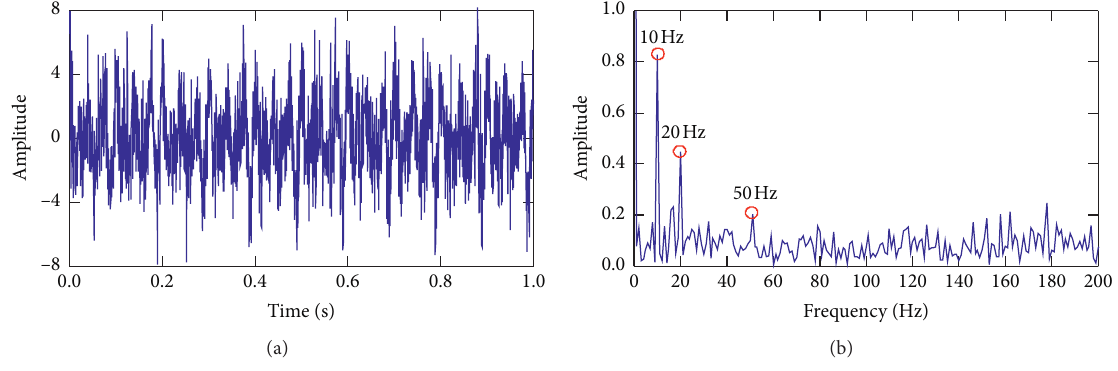
Figure 11: (a) The simulation signal y ′ ( t ) and (b) envelope spectrum for simulation signal y ( t ).